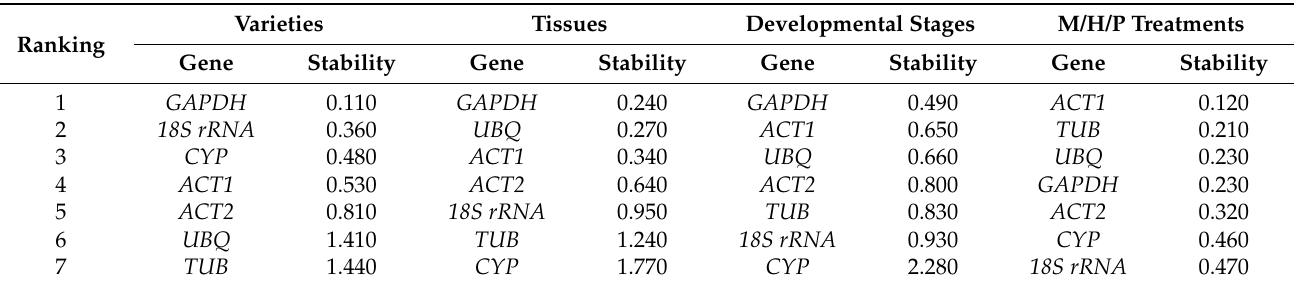
Table 4. Average expression stability values of seven candidate reference genes as calculated by NormFinder. M/H/P treatments means MT, HBR or PP treatments.